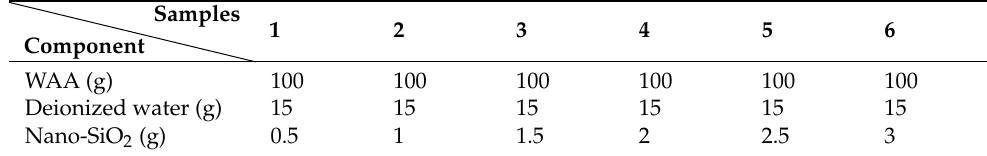
Table 1. The proportion of nano-SiO 2 in WAA resin in different samples.